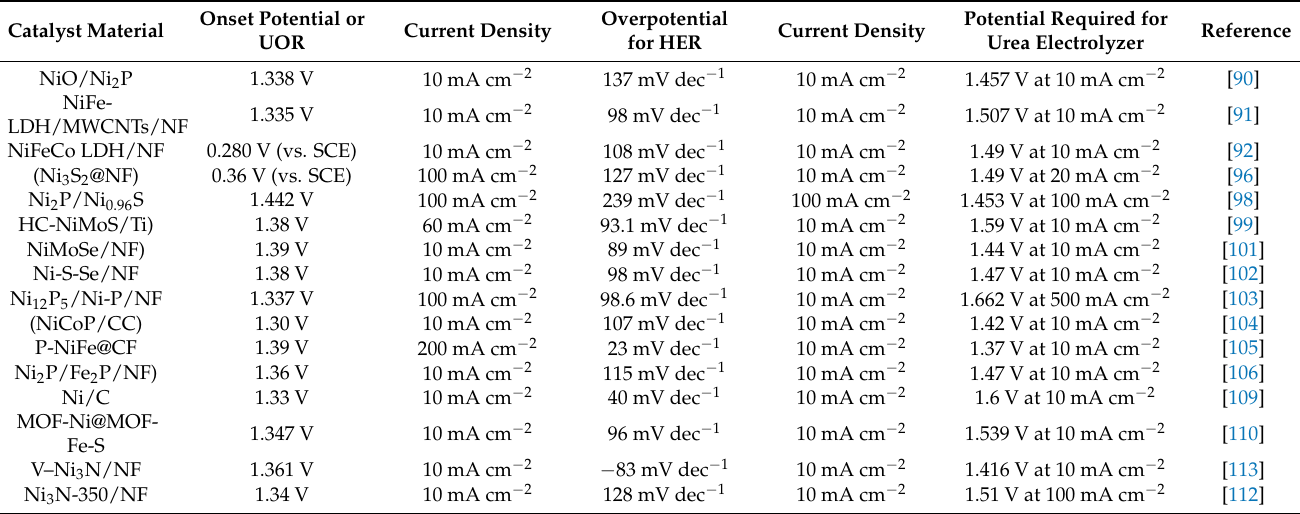
Table 3. Comparison of UOR and HER performance for bifunctional Ni-based electrocatalysts. Onset Potential or Overpotential Potential Required for Catalyst Material Current Density Current Density UOR for HER Urea Electrolyzer